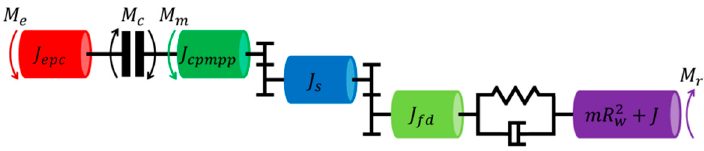
Figure 3. Dynamics model of the CPPHP.